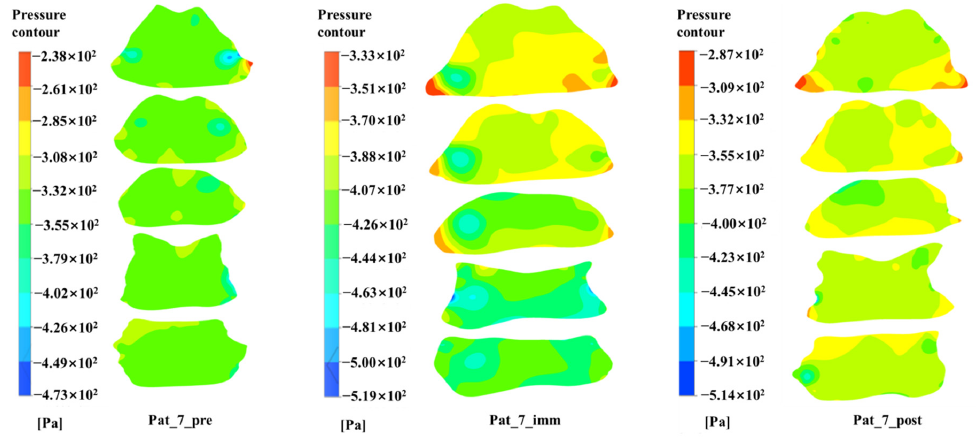
Figure 9. Pressure distribution in patient 7 between planes 1–5 (t = 1.25 s).